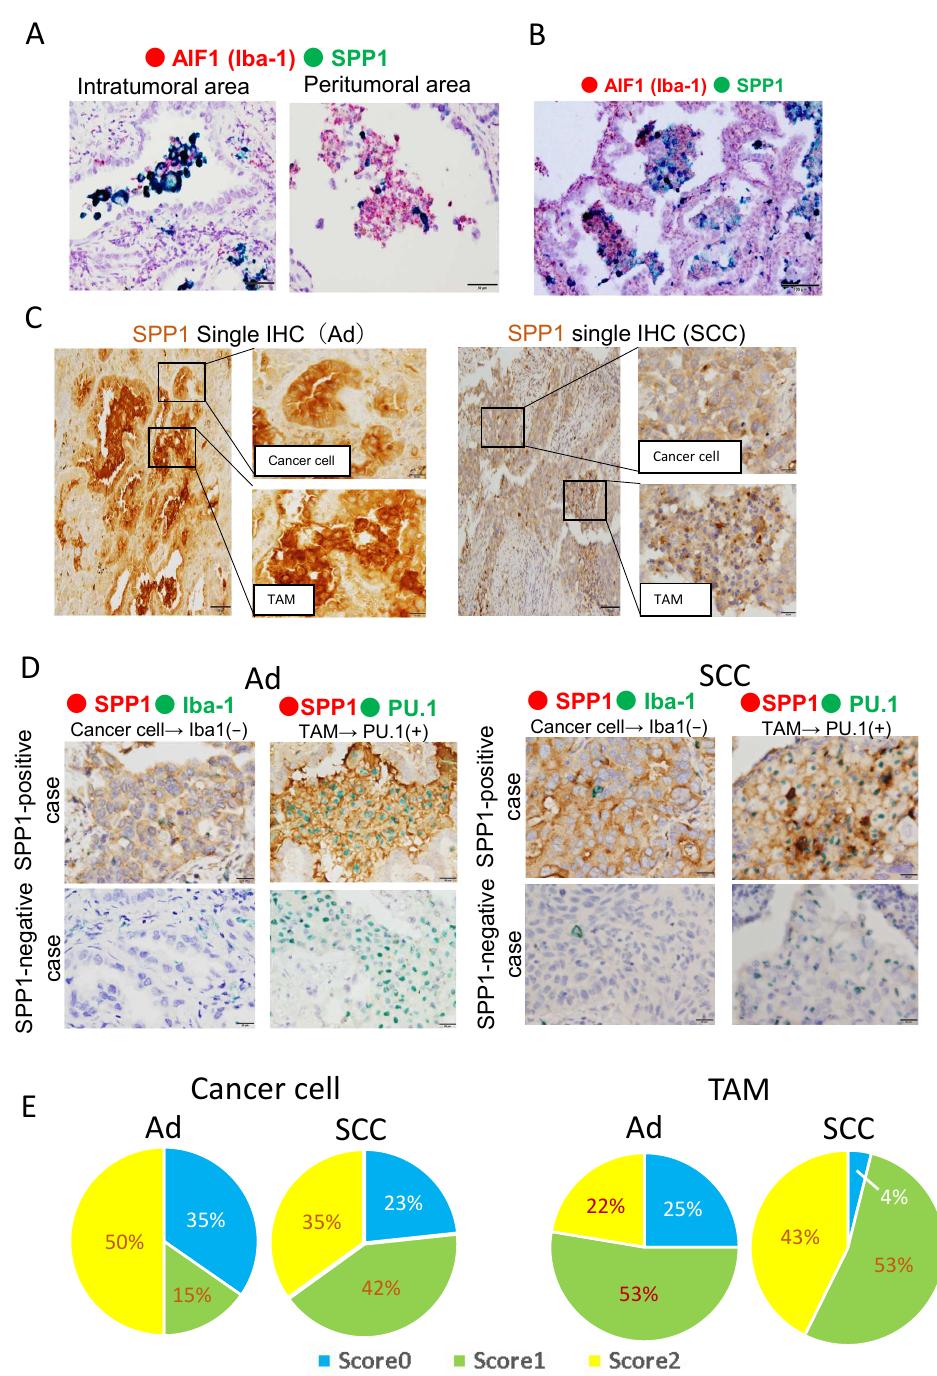
Figure 2. Evaluation of SPP1 expression on cancer cells and macrophages. ( A , B ). Representative dual ISH (green: SPP1; red: Iba-1) in adenocarcinoma. ( C ). Representative single-IHC of SPP1 in adenocarcinoma and SCC. ( D ). Double-IHC of SPP1 and Iba-1 to examine the SPP1 expression level in cancer cells (Iba-1-negative). Double-IHC of SPP1 and PU.1 to examine the SPP1 expression level on TAMs (PU.1-positive in the nucleus). ( E ). SPP1’s expression level was scored according to the proportion of stained cells as follows: less than 1% staining, score 0; 1% to 49% staining, score 1; more than 50% staining, score 2. The proportions of samples with each score among cancer cells and TAMs in adenocarcinoma and SCC are shown in the pie